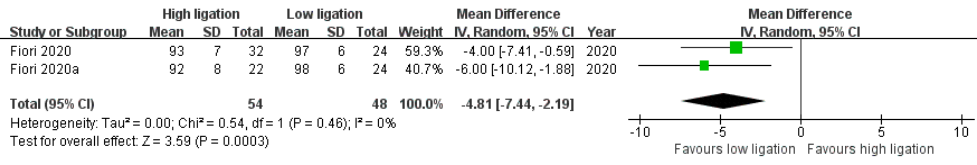
Figure 2. Forest plot of defecatory dysfunction assessed by the overall score of the fecal incontinence quality of life scale (short-term).